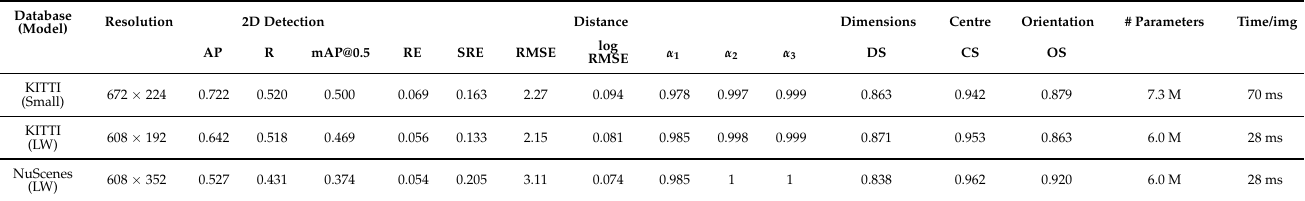
Table 1. Quantitative results of our new optimal model on a Jetson TX2. The tested models were trained on KITTI and